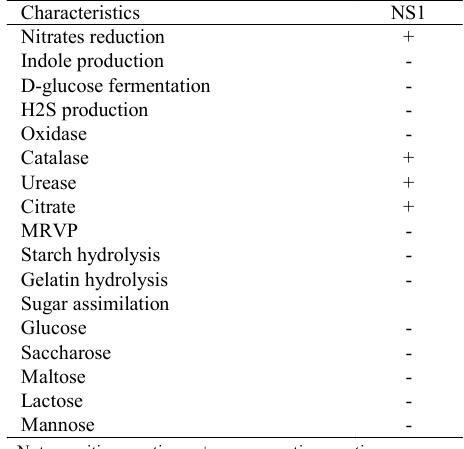
Note: positive reaction = +; negative reaction =